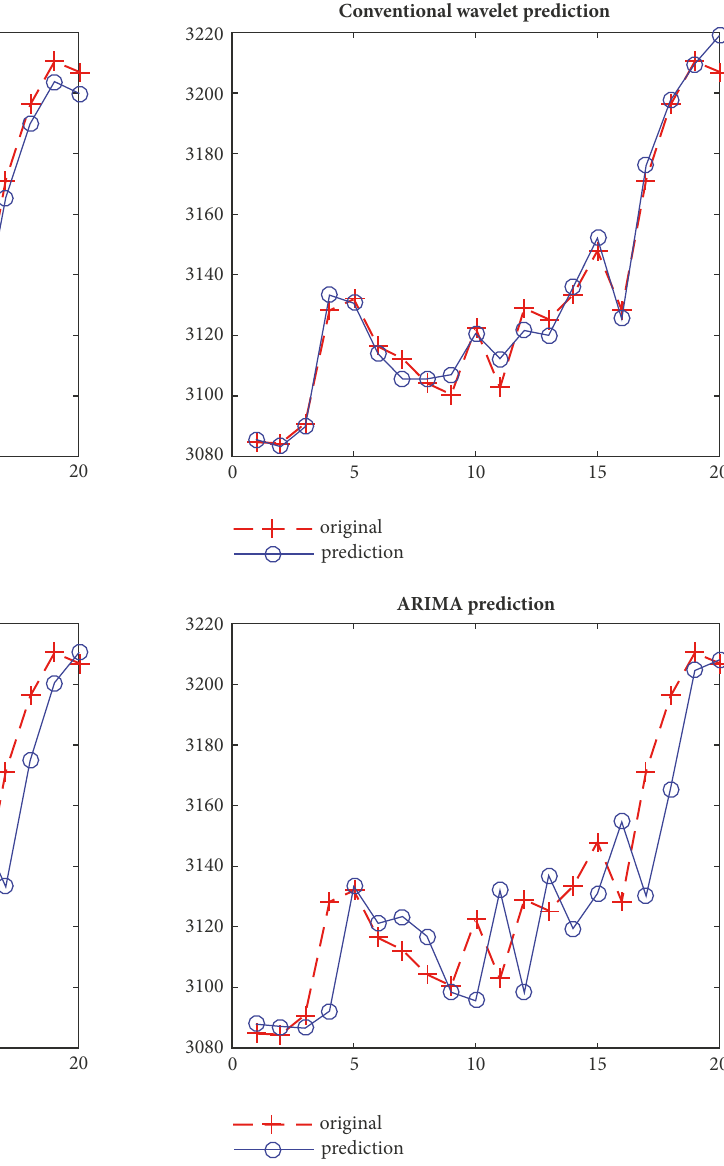
Figure 10: Comparison of the prediction results of Shanghai Stock Index.